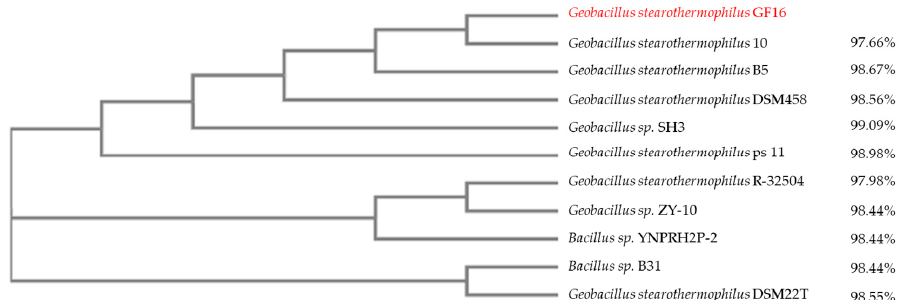
Figure 2. Schematic representation of a phylogenetic tree based on 16S rRNA sequences of different Geobacillus stearothermophilus strains. This is a neighbor-joining tree without distance corrections. The new isolate is highlighted in red. The sequence identity (%) to G. stearothermophilus GF16 is reported on the right.